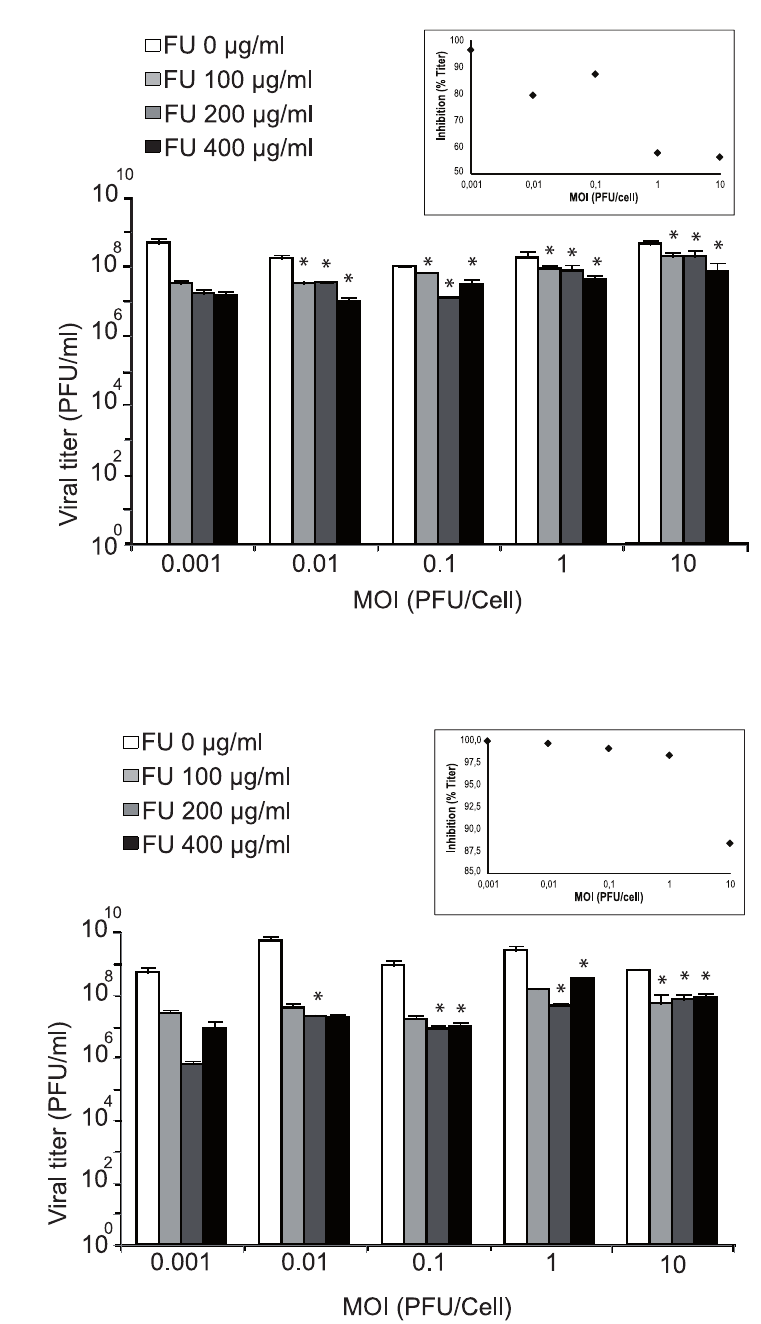
Figure 7. LCMV coinfections and reinfections of BHK-21 cells. Cells were infected with RFPrLCMV at the indicated MOI. At 0, 4, 8, 12 or 24 h p.i. cells were re-infected with GFPrLCMV at a MOI of 0.1 PFU/cell. The different panels show representative images of infected cells at 0 (A) and 48 (B) h p.i. with GFPrLCMV. Magnification is 20-fold. Nuclei were stained with DAPI. The origin of the marked RFPrLCMV and GFPrLCMV and procedures for the infections are described in Materials and Methods. Additional images of coinfections and reinfections at different MOI, and controls are depicted in Figures S1, S2 and S3.